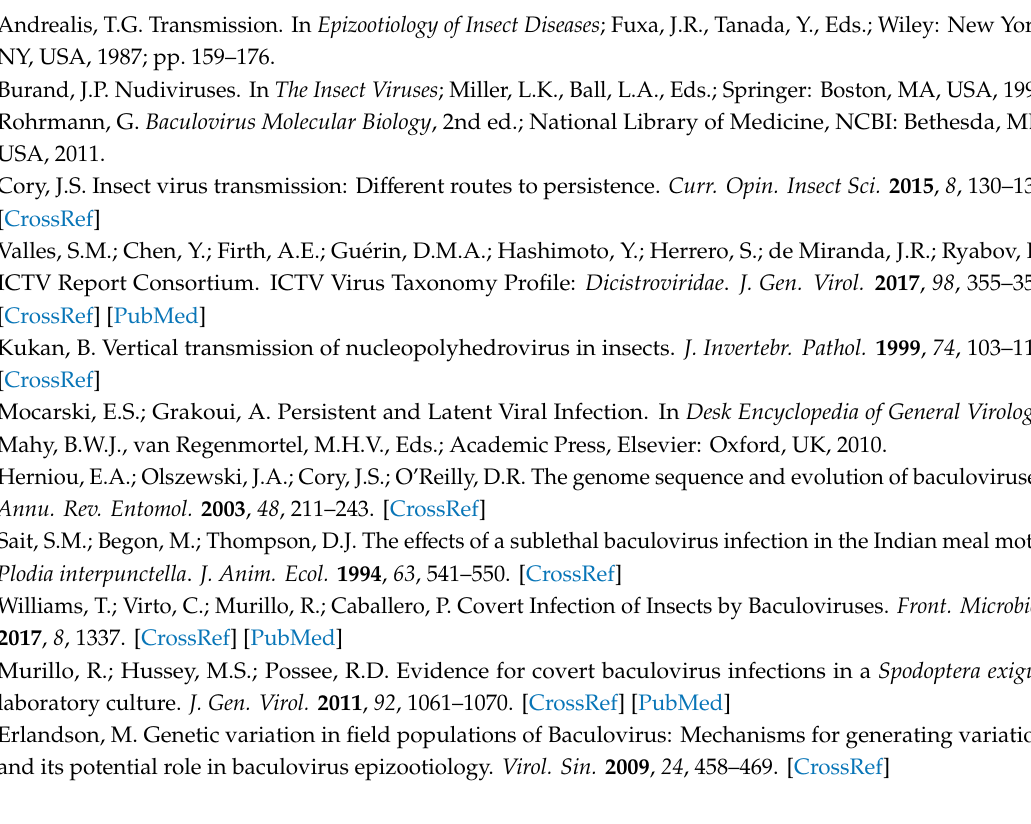
Table S1: Annotation of PhopGV-R compared to the reference isolate PhopGV-1346. Table S2: List of the SNP positions of PhopGV-R compared to the reference isolate